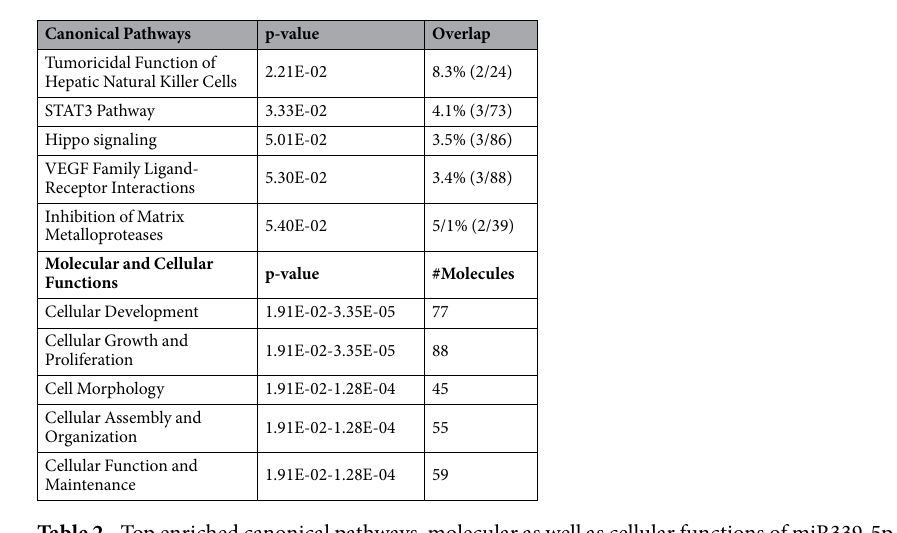
Table 2. Top enriched canonical pathways, molecular as well as cellular functions of miR339-5p based on Ingenuity Pathway Analysis. STAT3: Signal transducer and activator of transcription 3; VEGF: Vascular endothelial growth factor. P–value range for molecular and cellular functions represents the range of p-values generated for each subcategory and the respective molecules within each